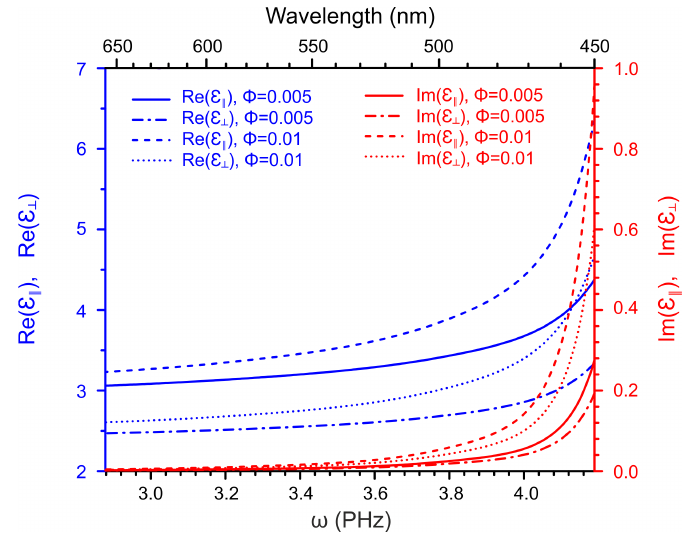
Figure 4. Frequency dependence of Re ( ε (cid:107) ) , Im ( ε (cid:107) ) , Re ( ε ⊥ ) and Im ( ε ⊥ ) of the nematic nanocomposite (host 5 CB plus AgNPs) for the two values of the NP volume fraction φ = 0.005 and φ = 0.01.